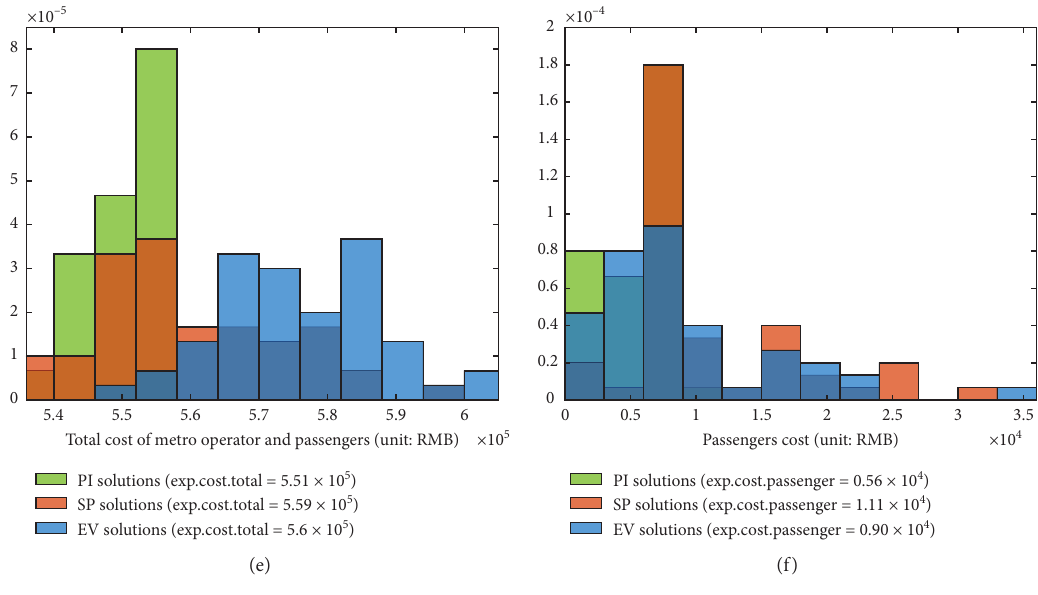
Figure 11: Out-of-sample evaluation of the SP, EV, and PI solutions. (a) Gaussian distribution: total cost; (b) Gaussian distribution: passenger cost; (c) Weibull distribution: total cost; (d) Weibull distribution: passenger cost; (e) uniform distribution: total cost; (f) uniform distribution: passenger